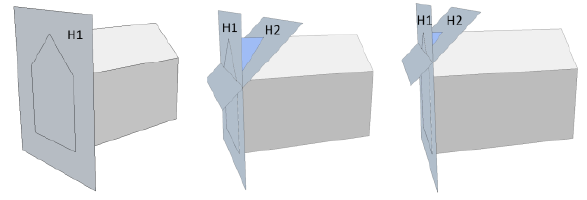
Figure 5. The ridge end features gable (left), hip (middle) and half-hip (right) with the half-spaces they introduce to the 3D model.